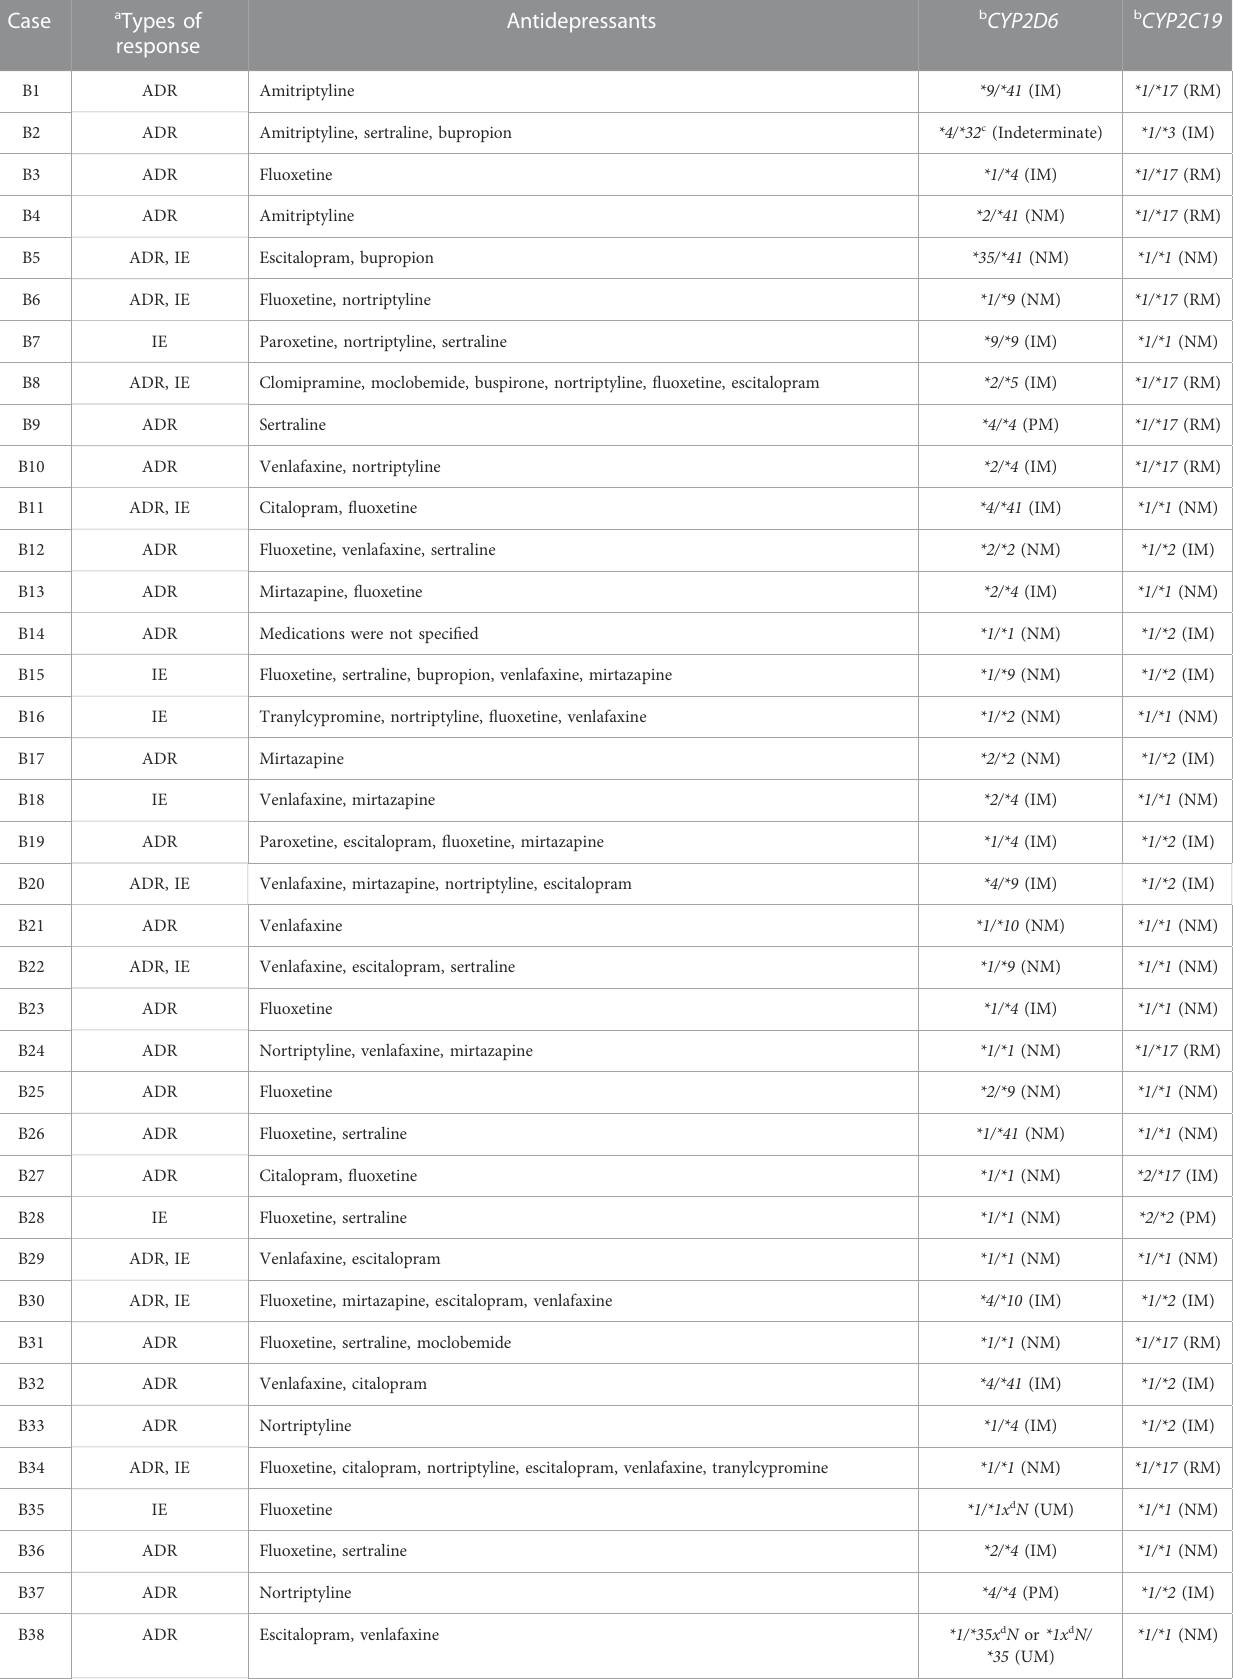
TABLE 2 Genotypes and phenotypes of recruited cases (N = 52).